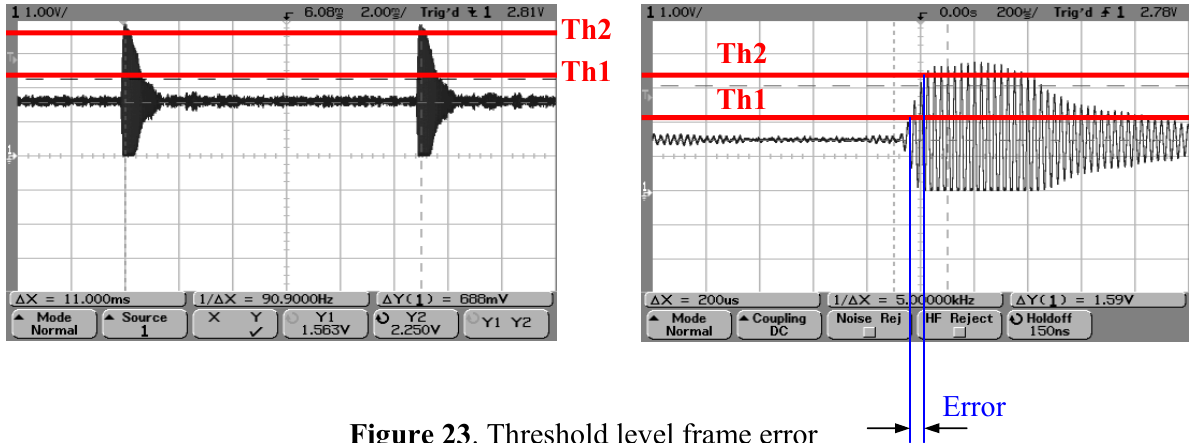
Figure 23 . Threshold level frame